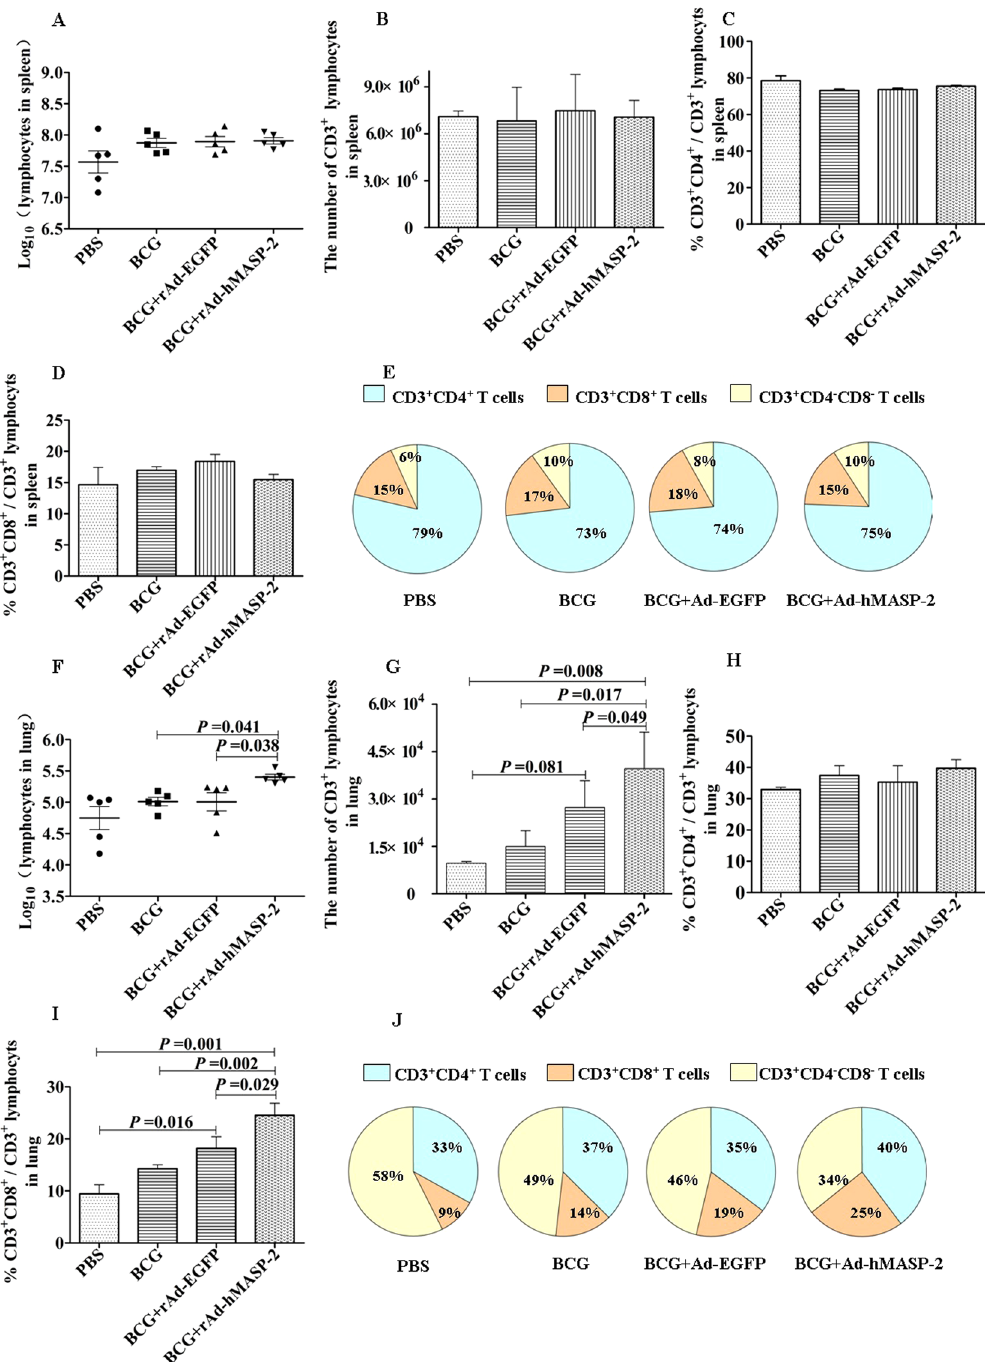
Figure 8. The number of lymphocytes and percentage of CD3 + CD4 + and CD3 + CD8 + cells within splenocytes ( A ~ E ) and pneumonocytes ( F ~ J ) in BCG-infecteded mice after treated intratracheally with rAd-hMASP-2. At day 21, isolated lung and spleen cells from mice were stained with PerCP-conjugated anti-CD3, PE-conjugated anti-CD4 andAPC-conjugated anti-CD8. CD3 + CD4 + and CD3 + CD8 + T-cell subgroup were detected via FCM, n = 5 per group. FACS analysis of T lymphocyte subsets showed no difference among various groups in total number of spleen lymphocytes ( A ) and CD3 + lymphocytes ( B ), percentage of CD3 + CD4 + ( C ) and CD3 + CD8 + ( D ) lymphocytes within splenocytes. ( E ) The CD3 + lymphocyte subsets distributed in the spleen of various groups. As compared with the rAd-EGFP group, ( E ) lung lymphocytes total number (2.56 × 10 5 ± 6.41 × 10 4 ) and ( F ) CD3 + lymphocytes (4.43 × 10 4 ± 6.1 × 10 3 ), ( H ) CD3 + CD8 + lymphocytes percentage (24.55% ± 2.29%) in rAd-hMASP-2 group showed statistically significant increased. ( J ) The CD3 + lymphocyte subsets distributed in the lung of various groups. Data collected from five mice per group were expressed as means ±